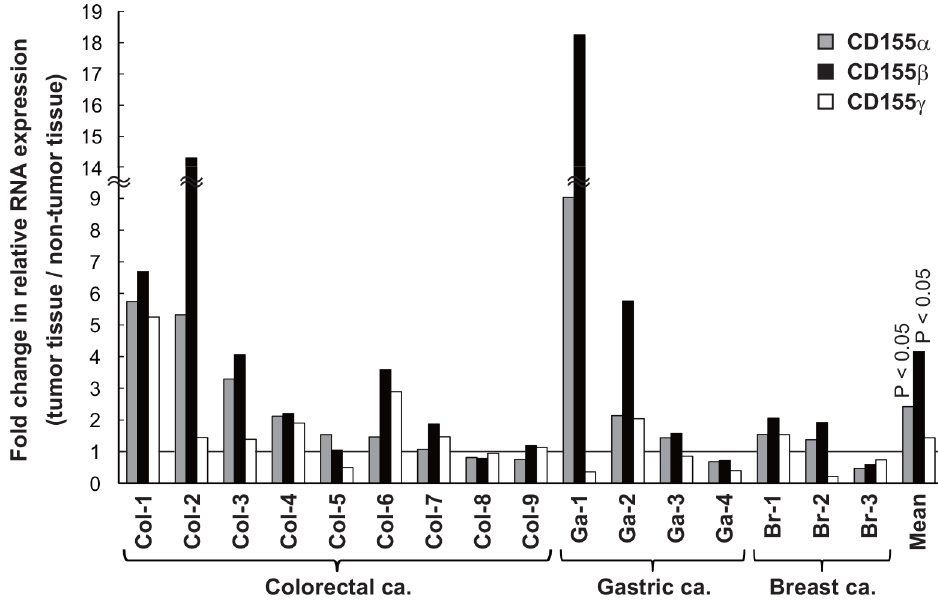
Fig 2. Expression of CD155 α and CD155 β in tumor tissues was higher than that of non-tumor tissues. Tumor and adjacent non-tumor tissues were taken from surgical resection specimens of colorectal (adenocarcinoma, n = 9), gastric (adenocarcinoma, n = 4), and breast (invasive ductal carcinoma, n = 3) cancers. qRT-PCR of CD155 RNA splicing variants was performed, and the fold change of relative expression of the tumor tissue versus the adjacent non-tumor tissue was calculated. The expression of membrane-bound ( α ) and soluble ( β ) CD155 RNA in the tumor tissues was significantly higher than that of the non-tumor tissues (P <